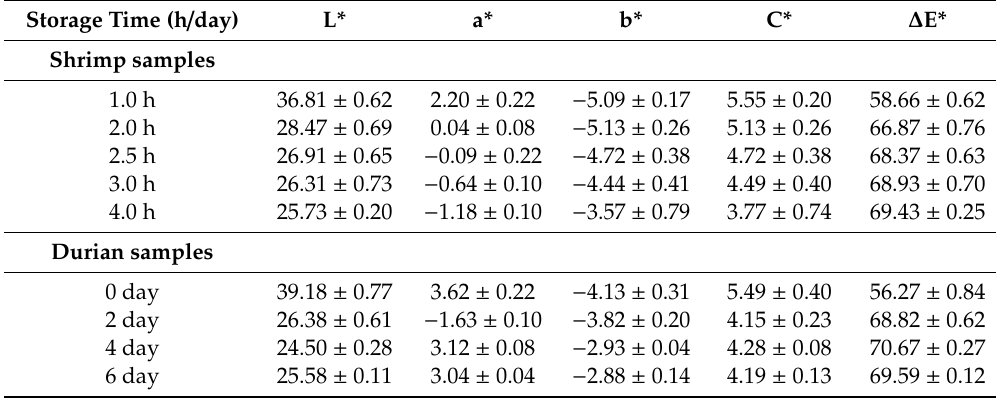
Table 4. Parameters changes (L*, a*, b*, C* and ∆ E*) of sensing film for packaged shrimp and durian stored at ambient temperature (28 ± 1 ◦